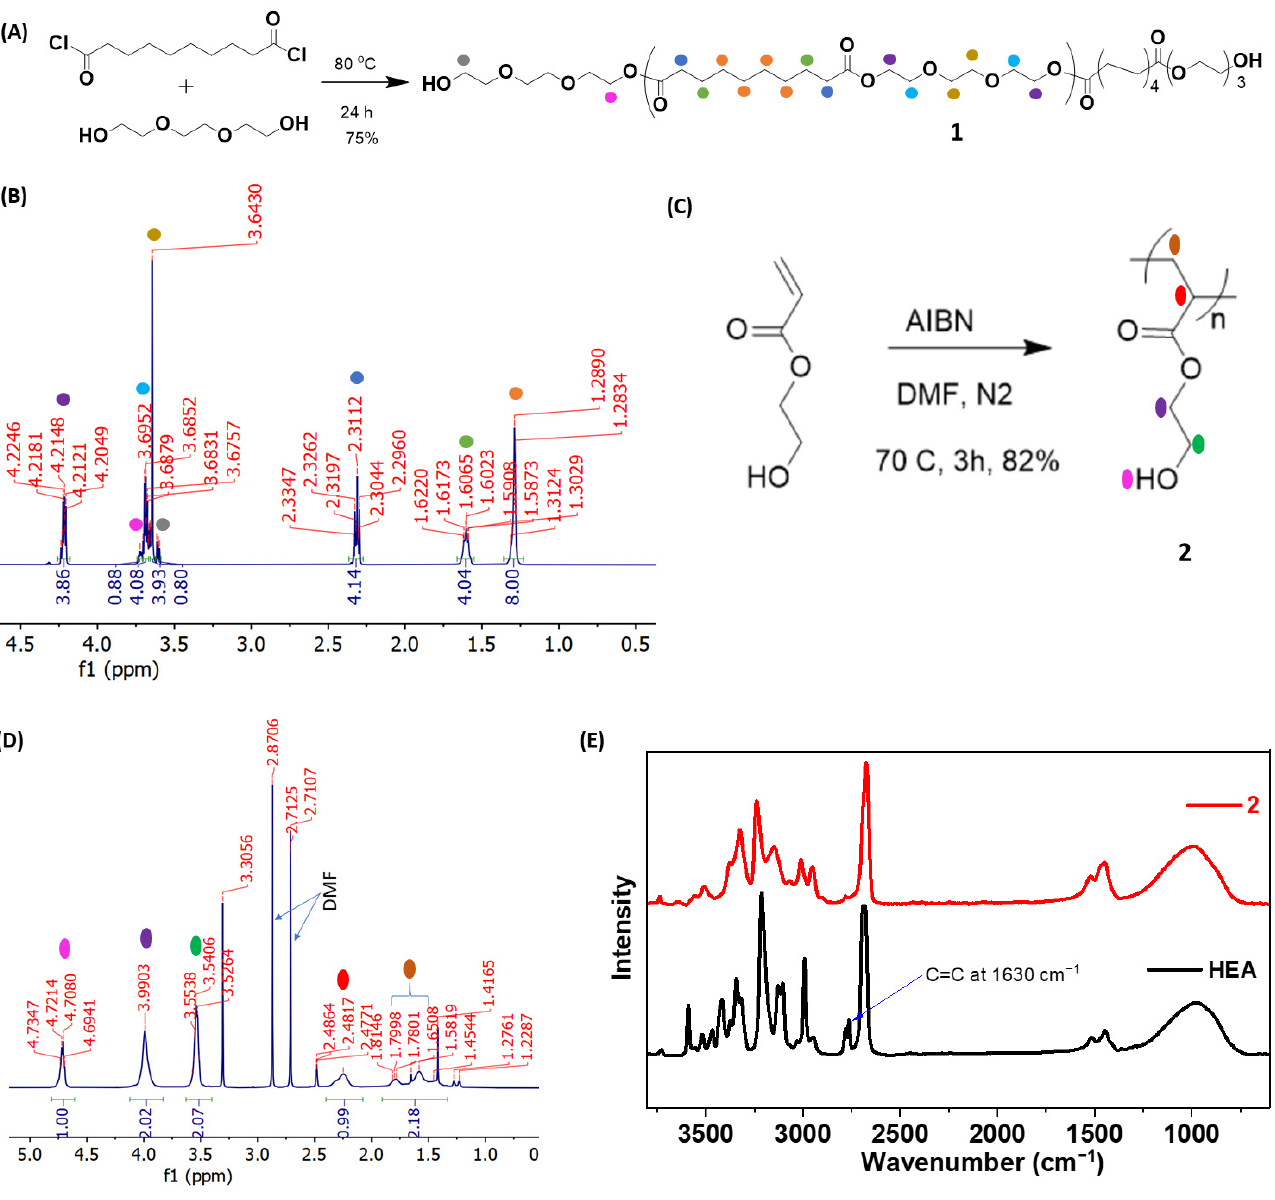
Figure 2. ( A ) Bulk polymerization of sebacoyl chloride and triethylene glycol at 80 °C. ( B ) 1 H NMR spectrum of Polymer 1 . ( C ) Free radical polymerization of HEA monomer. ( D ) 1 H NMR spectrum of Polymer 2. ( E ) Comparison of FTIR spectra of HEA monomer and Polymer 2 .